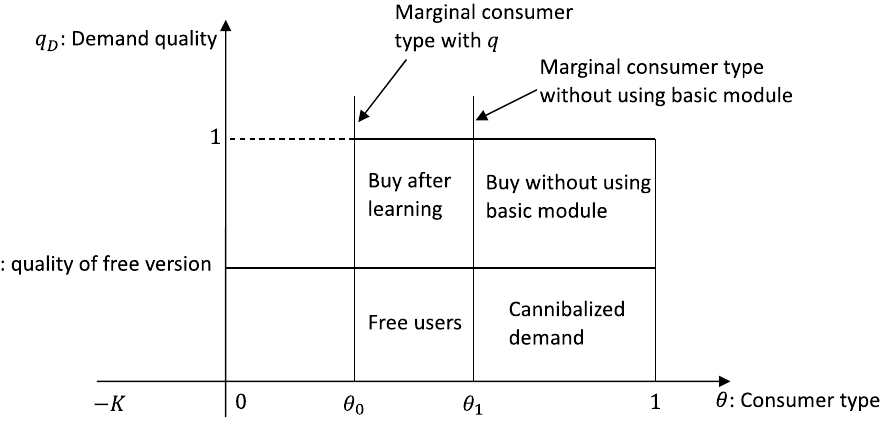
Figure 1. The distribution of potential consumers.